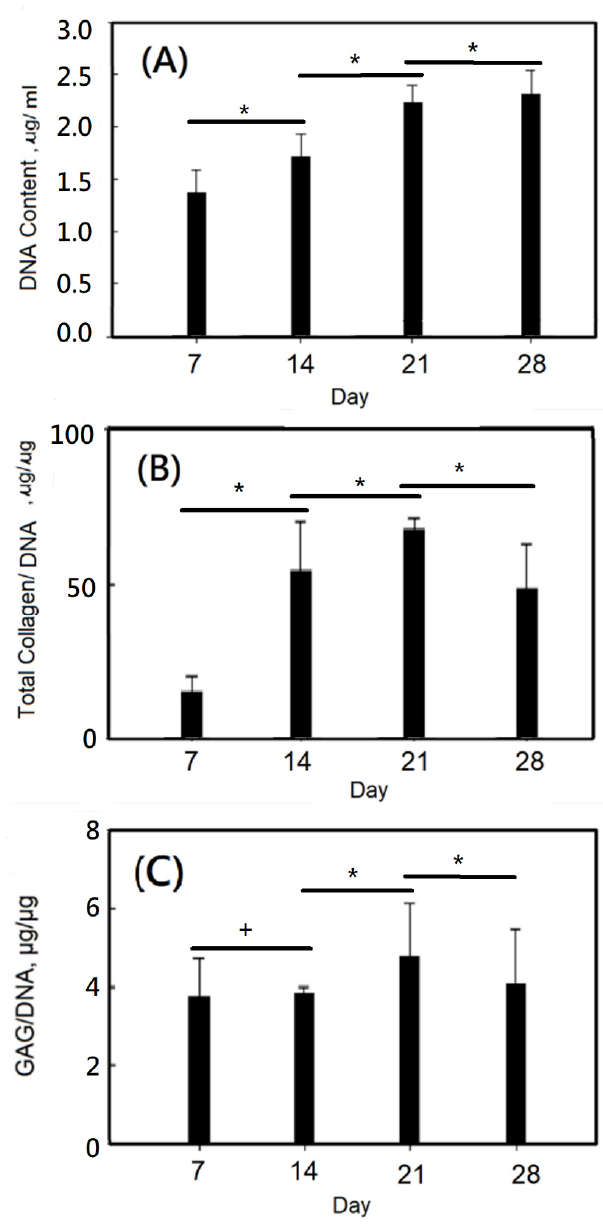
Figure 12. ( A ) DNA content of dynamic culturing chondrocytes on gelatin-based hydrogel scaffolds, ( B ) total collagen/DNA of dynamic culturing chondrocytes on gelatin-based hydrogel scaffolds, and ( C ) GAG/DNA of dynamic culturing chondrocytes on gelatin-based hydrogel scaffolds. Values with different superscripts were significantly different ( p < 0.05); *, statistical significance between the groups ( p < 0.05); +, nonsignificance within the group ( p > 0.05); n = 6.